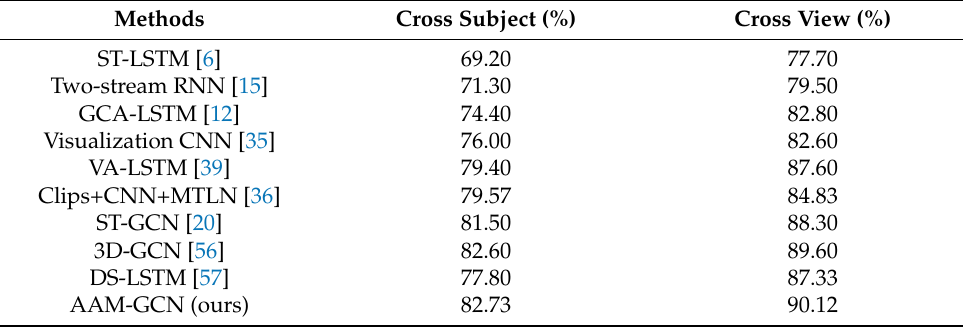
Table 2. Comparison results of various methods on the NTU RGB+D